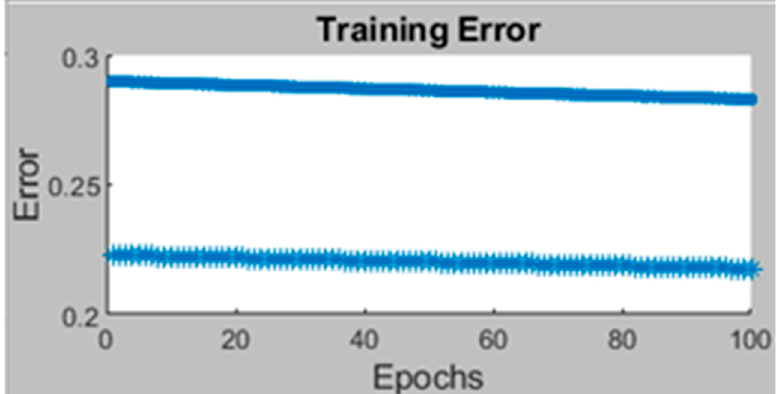
Figure 25. RMSE plot for grid partitioning of ANFIS